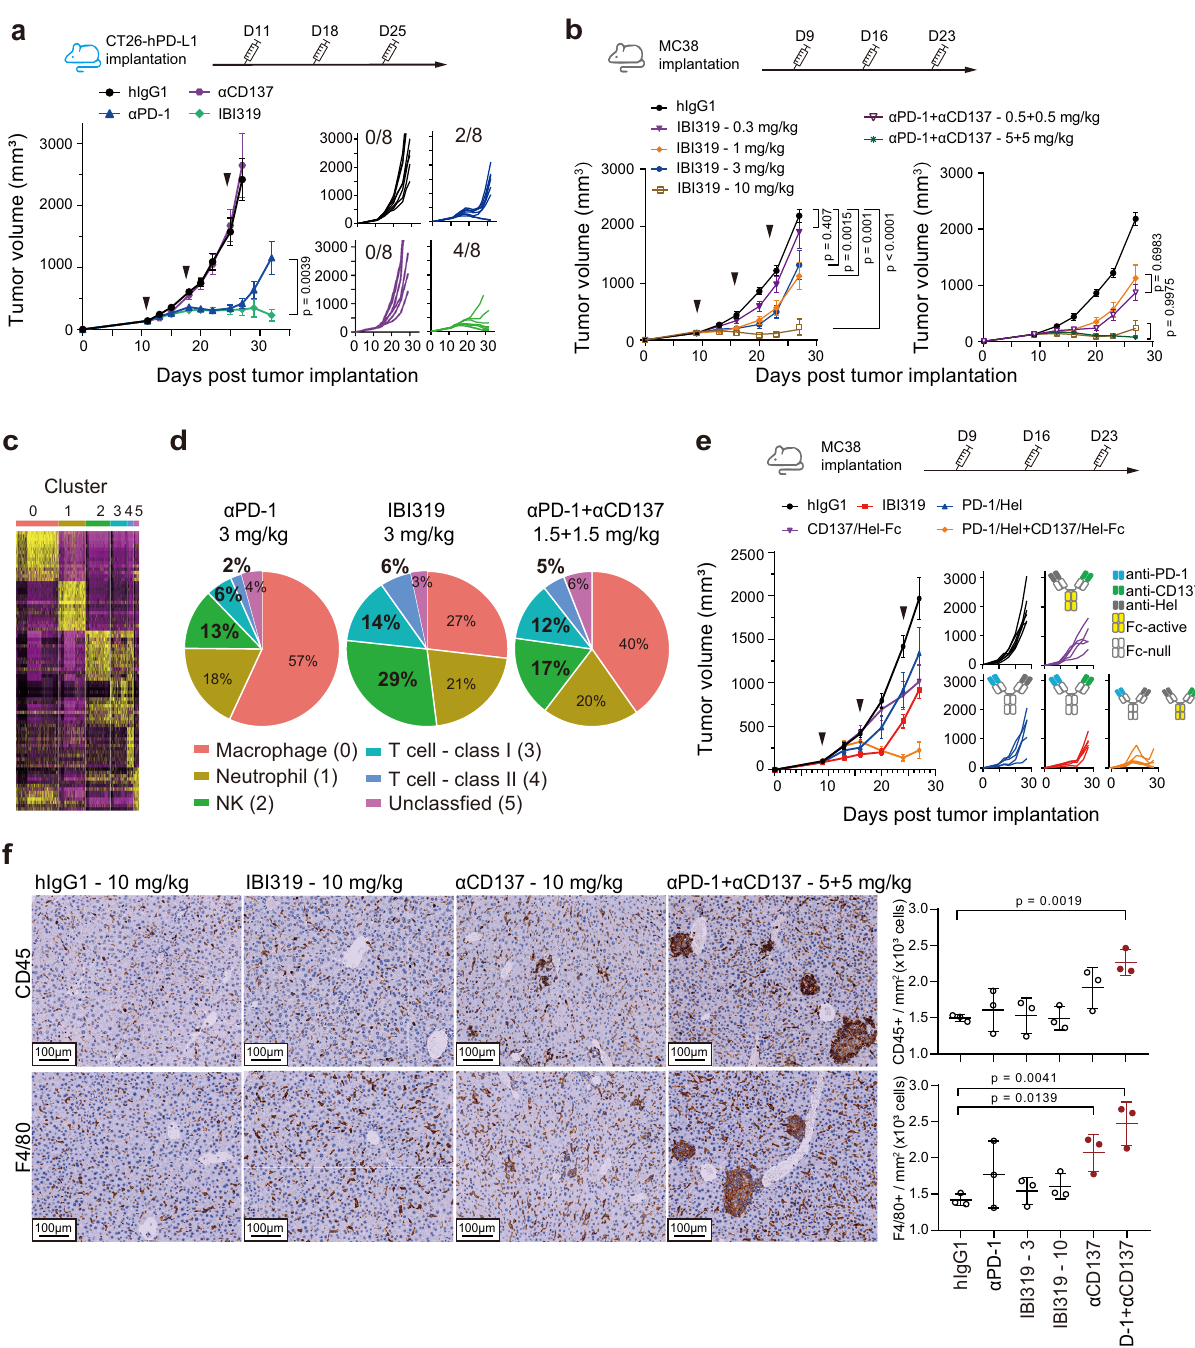
Fig. 3 IBI319 shows strong antitumour ef fi cacy while avoiding hepatotoxicity in mouse models. a (Left) Tumour volumes of CT26-hPD-L1 tumours in BALB/c-hPD-1/hPD-L1/hCD137 mice treated with the indicated antibodies (20 mg/kg, i.p.) on days 11, 18 and 25 post-tumour implantation ( n = 8 per group). The mice in the hIgG1 and α CD137 groups were euthanized on day 27 post-tumour implantation due to ethical issues. (Right) Spaghetti plots show the individual tumour volumes in each group. The numbers in the plots indicate tumour-free mice/all. b Tumour volumes of MC38 tumours in C57BL/6- hPD-1/hCD137 mice treated with the indicated antibodies on days 9, 16 and 23 ( n = 7 per group). c and d Single-cell RNA sequencing of CD45 + cells in MC38 tumours after antibody treatments. c A thumbnail heatmap showing the expression of signature genes in each cell cluster (detailed heatmap in Supplementary Fig. 4b). d The percentages of different cell clusters in the α PD-1, IBI319 and α PD-1 + α CD137 groups. e Tumour volumes of MC38 tumours in C57BL/6-hPD-1/hCD137 mice treated with the indicated antibodies (3 + 3 mg/kg for the α PD-1/Hel + α CD137/Hel-Fc group and 3 mg/kg for all other groups) on days 9, 16 and 23 ( n = 6 per group for the IgG1 and α PD-1/Hel + α CD137/Hel-Fc groups; n = 5 per group for all other groups). Hel: hen egg white lysozyme. f Livers from the mice in b were stained for CD45 and F4/80 via IHC. (Left) Representative images. (Right) Quanti fi cation of whole pathological digital slides via HALO software ( n = 3 per group, mean and SD); images of all quanti fi ed groups can be found in Supplementary Fig. 5b. a , b and e Tumour volumes are presented as the mean, and the error bar represents the SEM. Statistics were performed in the indicated groups: two-way ANOVA with Tukey ’ s multiple comparisons test ( a and b ) and two-sided, un-paired t test ( f ); p values are indicated in the